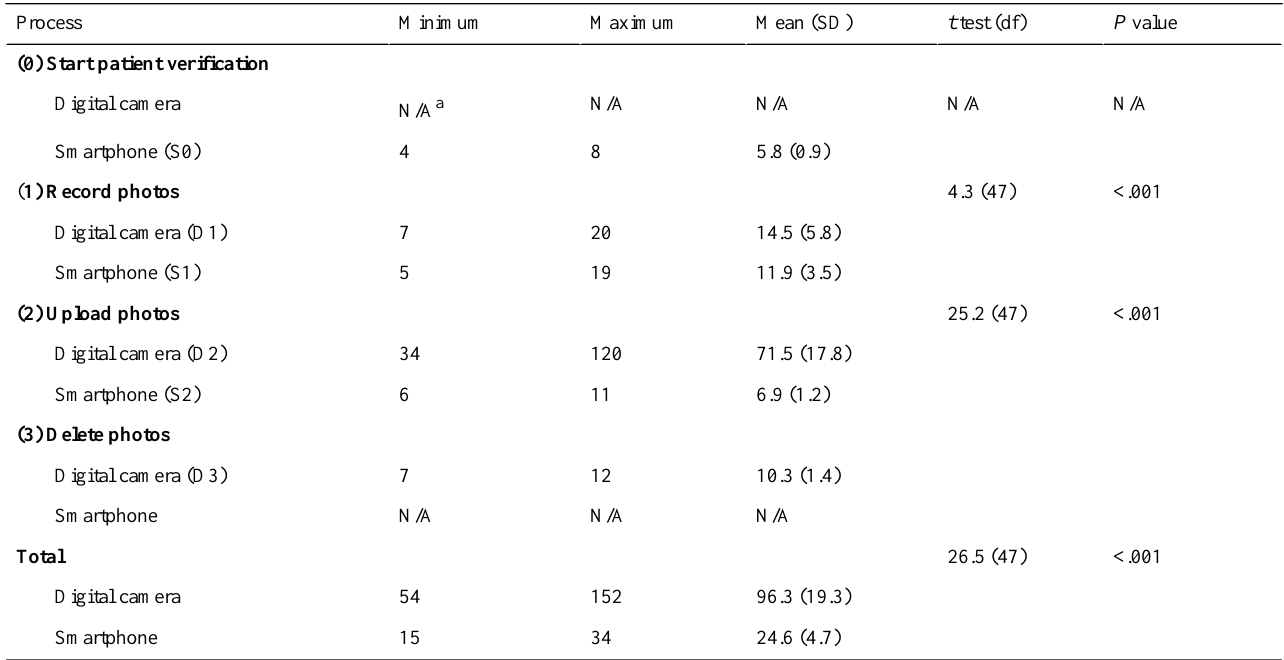
Table 2. Time spent on individual segmented processes (in seconds).